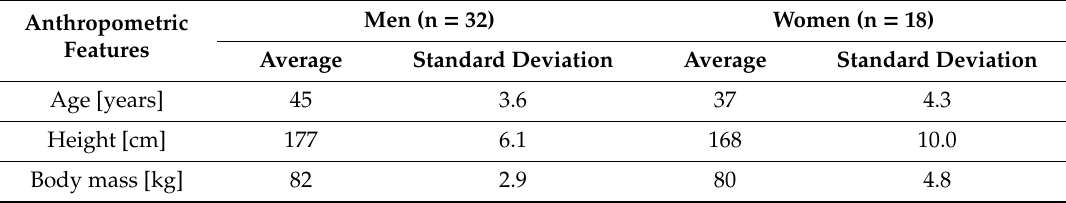
Table 1. Anthropometric characteristic of the surveyed farmers (N =